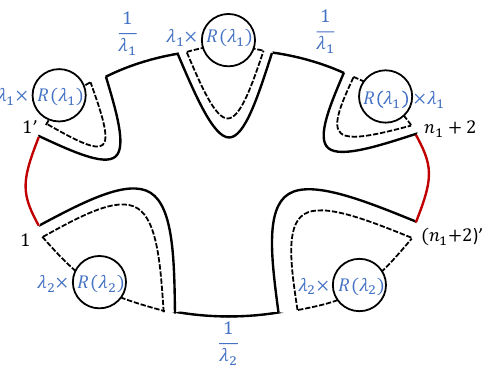
Figure 35 . Contribution from a fixed m 1 = 2 and m 2 = 1 to all n 1 and n 2 in the expression for F c ( λ 1 , λ 2 ) in (G.10). The solid loop gives a factor of d D Z m 1+ m 2+2 ,B 0 m 2 and m 2 + 1 factors respectively of 1